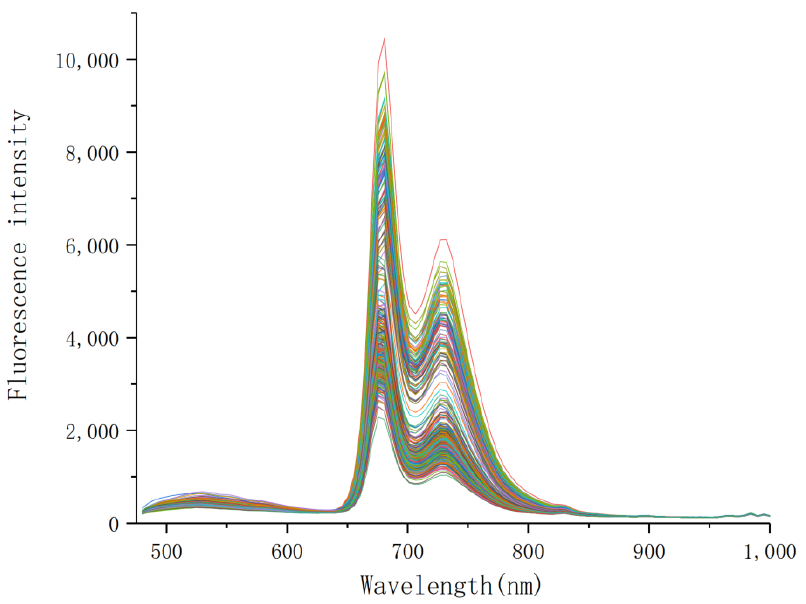
Figure 4. Raw spectra of tea.